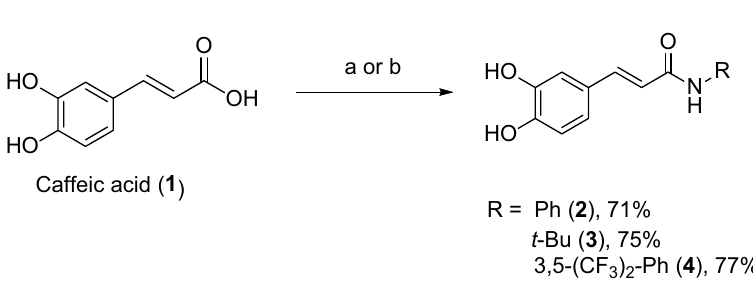
Figure 2. Syntheses of caffeic acid amide derivatives; ( a ) aniline or tert -butyl amine, EDCI . HCl, HOBt,